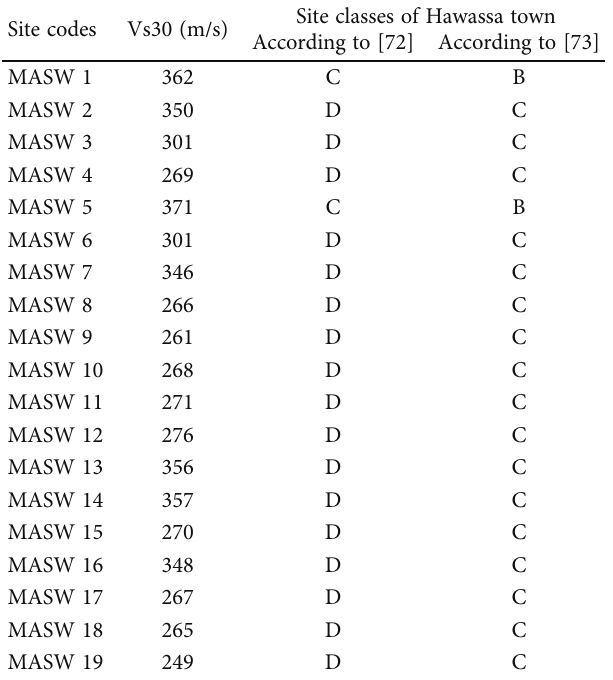
Table 5: Vs30 values of the respective site classes in Hawassa town. Site